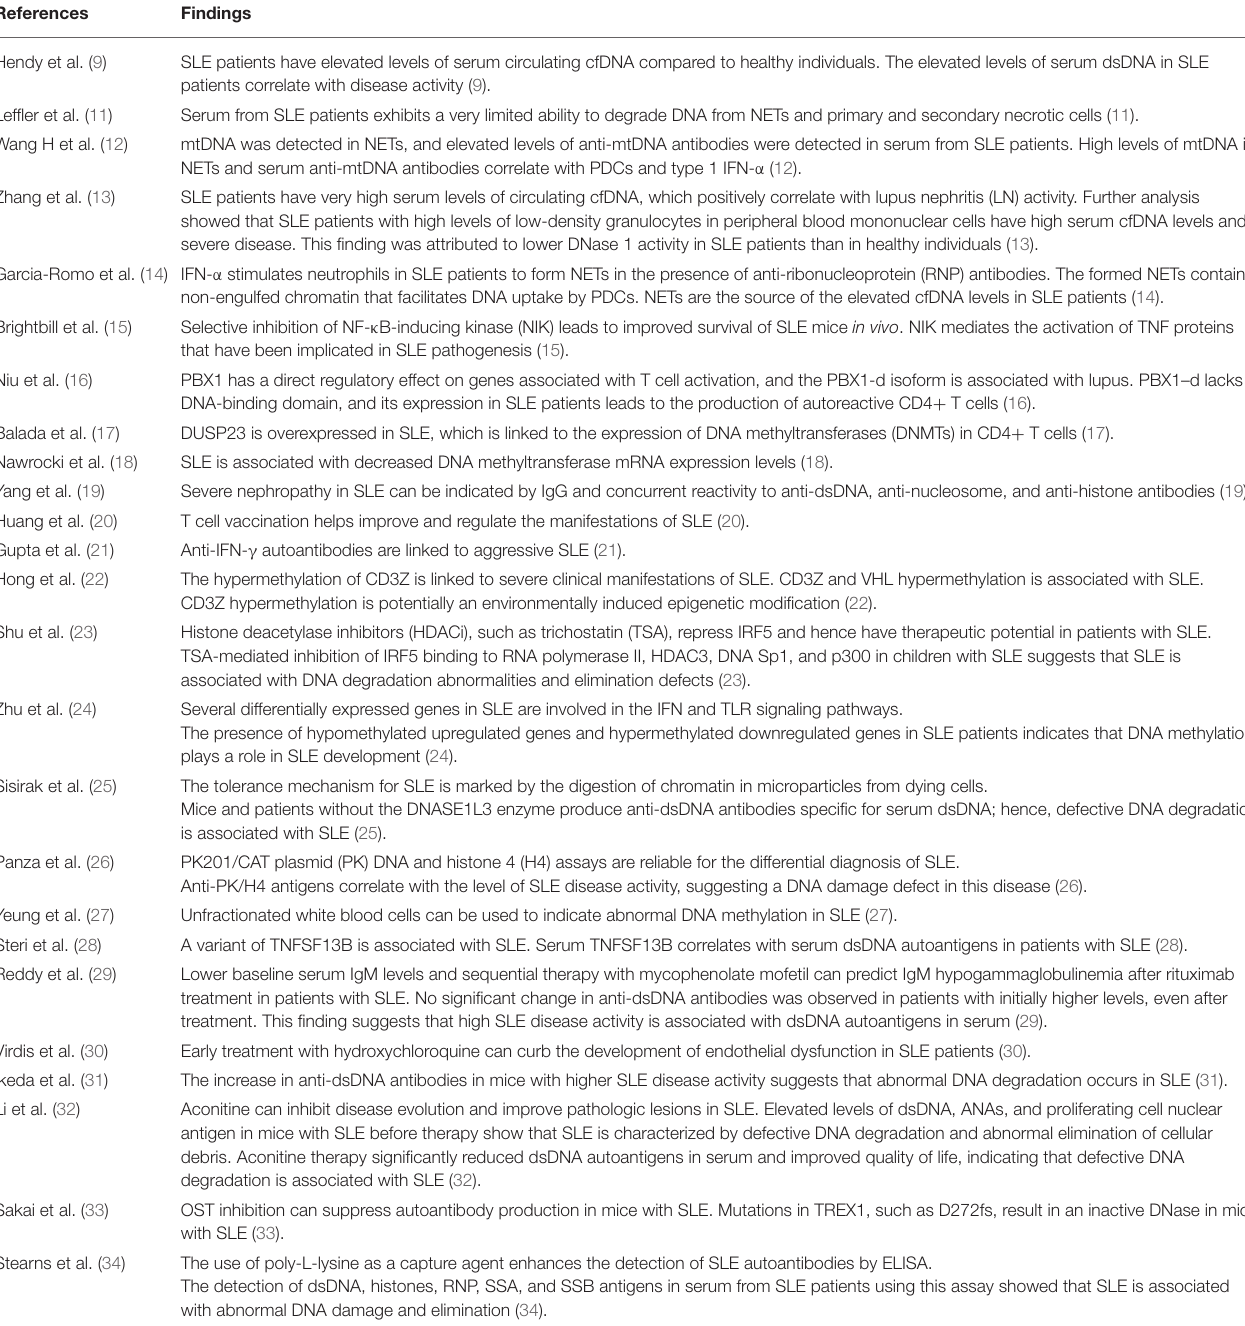
TABLE 2 | Findings from each